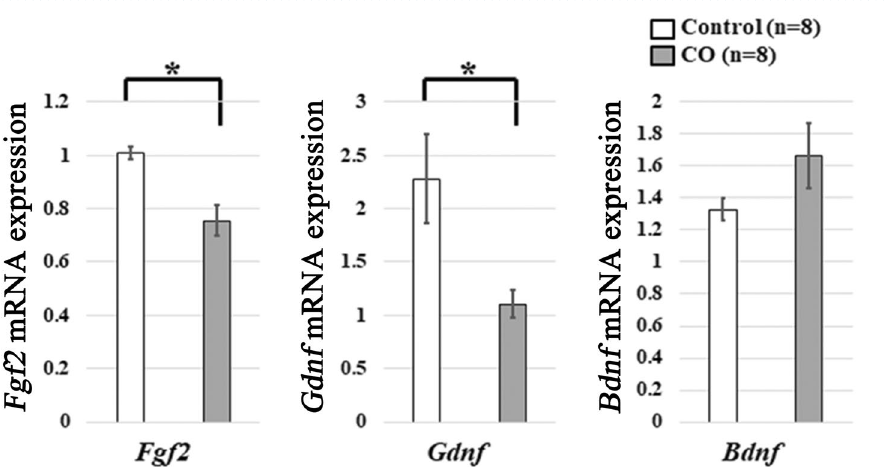
Figure 5. mRNA expression of neurotropic factors in neural precursor cells and glial cells. The mRNA expression of Fgf2 and Gdnf is significantly lower in the CO rats 21 days after CO exposure than in the controls, and the mRNA expression of Bdnf is not significantly different between CO rats and controls. Values are expressed as mean ± SEM. * p <